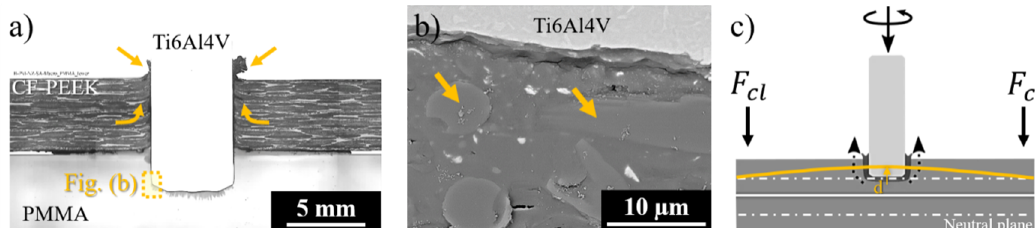
Figure 9. ( a ) Cross-section of the friction-riveted joint with upper CF-PEEK and lower poly-methyl-methacrylate (PMMA) parts. ( b ) Detail of the metal-PMMA interface showing broken fiber embedded in PMMA in the rivet surroundings ( c ) Schematics of the initial joining stage showing possible bending of the upper composite plate and the upward material flow. (Joining parameters—RS: 15000 rpm, FF: 15 kN, DF: 7.5 mm, CP: 0.2 MPa).